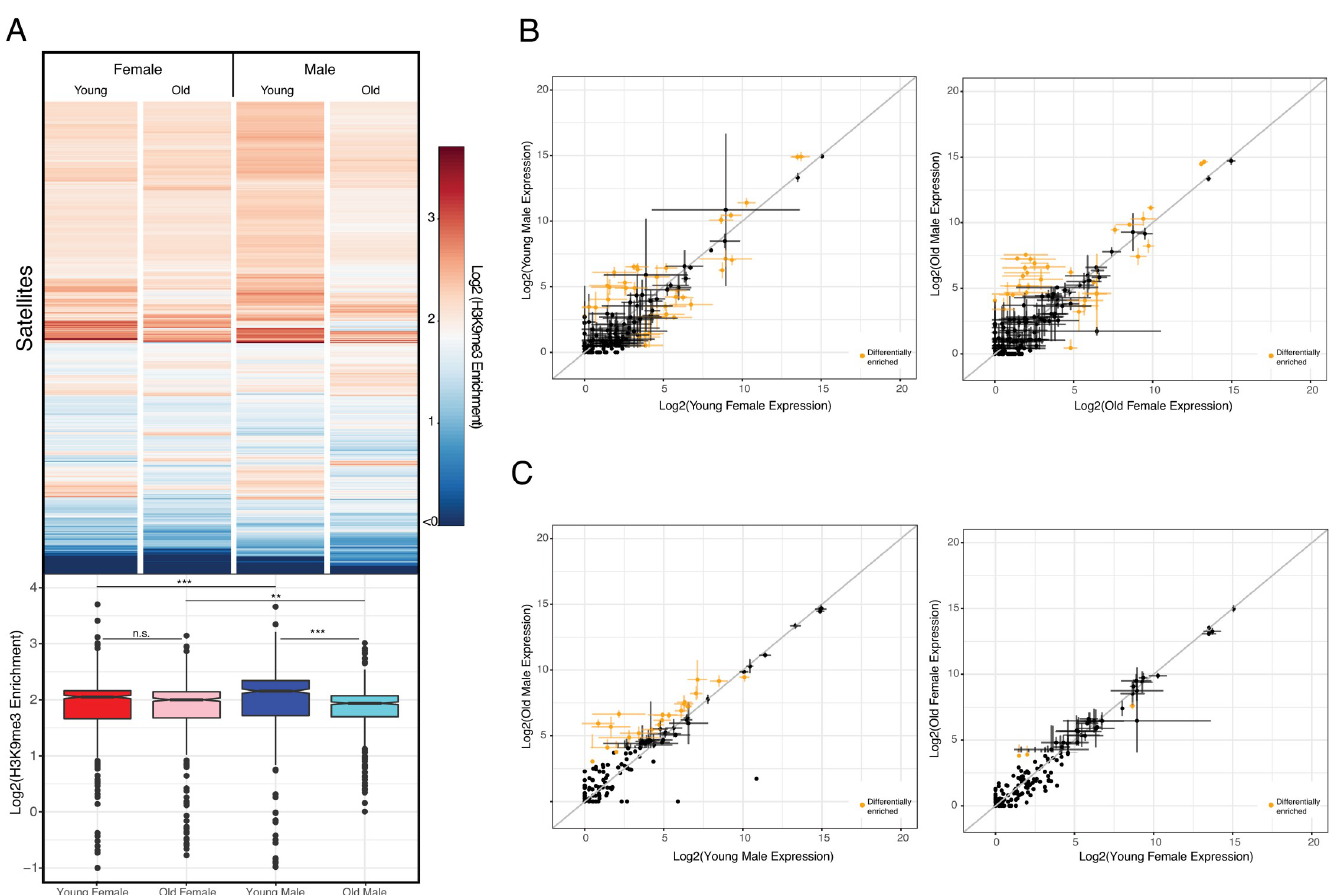
Fig 7. Heterochromatin and expression at satellite DNA. A. Average log2 H3K9me3 enrichment at different satellite DNA for young and old females and males. Boxplots with significance values calculated using the Wilcoxon test ( � p < 0.05, �� p < 0.01, ��� p < 1e-5). B. Log2 expression differences between young (left) and old (right) males and females. Data represents mean value of 3 replicates with bars denoting standard error, data in yellow denote significant differentially expressed satellites (50% higher or lower expression, Wald test, p < 0.05). Grey line denotes 1:1 expression levels between the samples. C. Log2 expression differences between young vs. old males (left) and females (right). Plots made in similar fashion as in B .